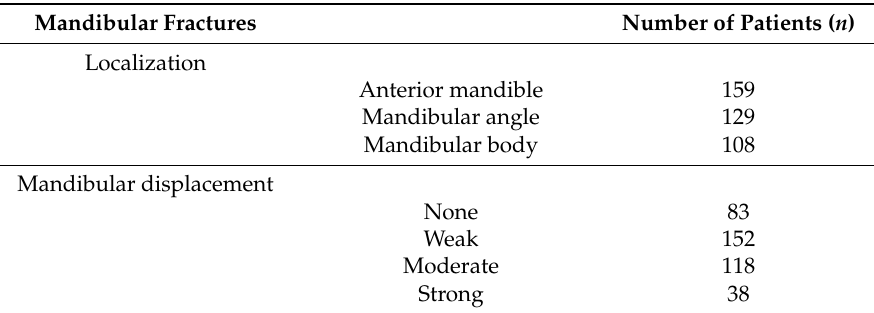
Table 2. Fracture characteristics.